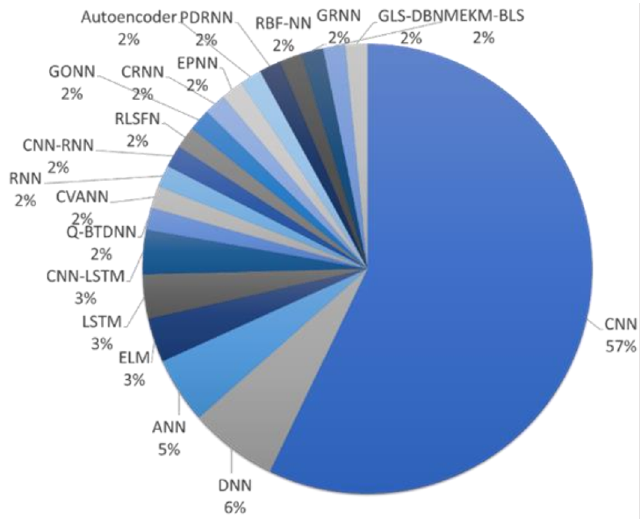
Figure 14. Pie chart representation of various deep learning models proposed for automated PD detection studies in this